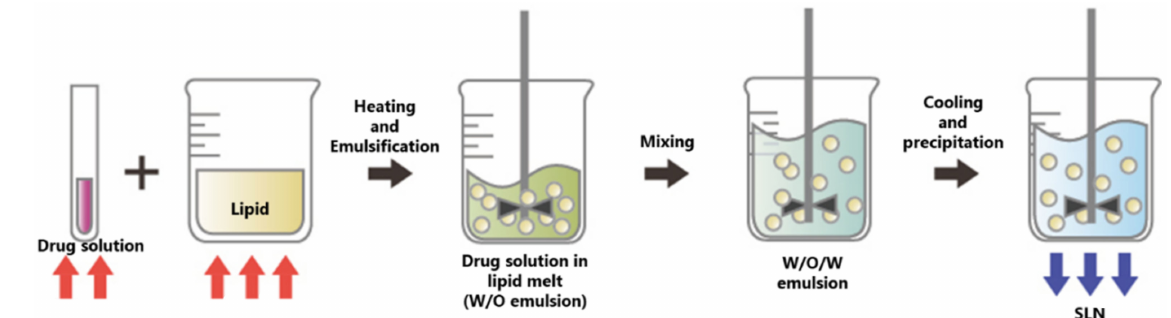
Figure 13. The procedure of double emulsion